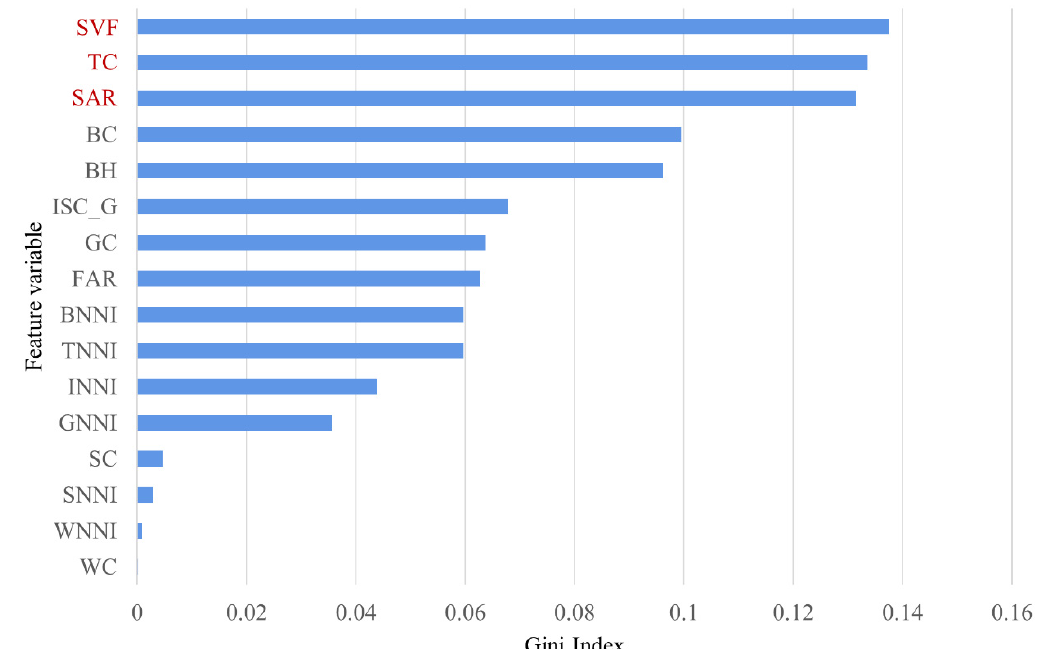
Figure 8. Variable importance ranking for UFZ mapping revealed by the RF algorithm.